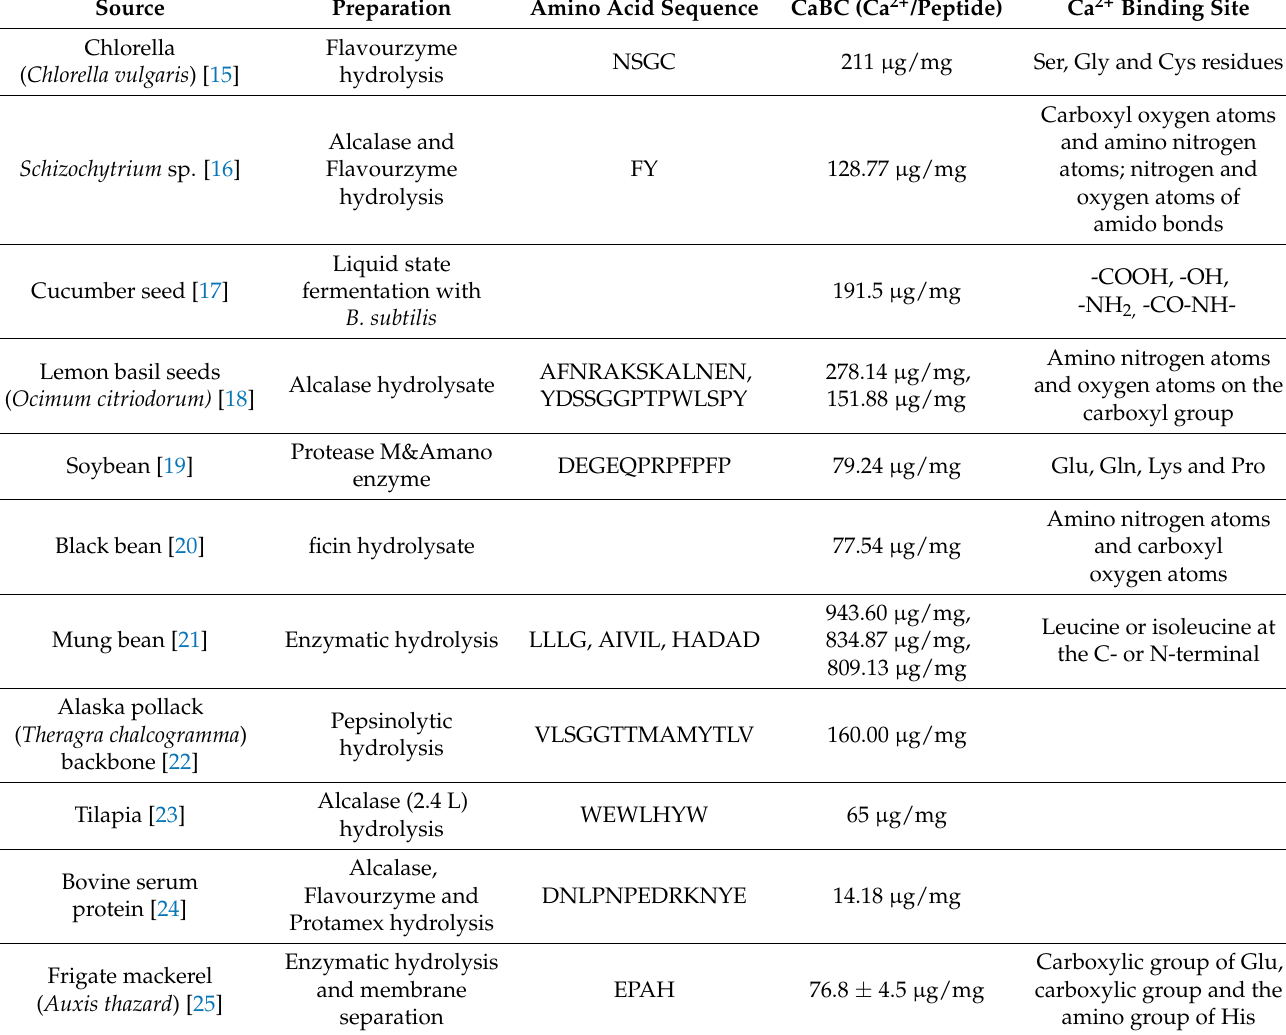
Table 1. Peptides with calcium binding capacity (CaBC) and their various